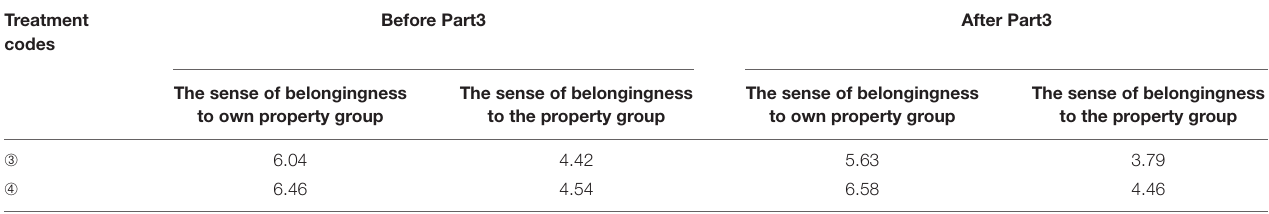
TABLE 8 | Tenant-household identities and pro-environmental behavior. Frequencies of PEB Tenant-household identities